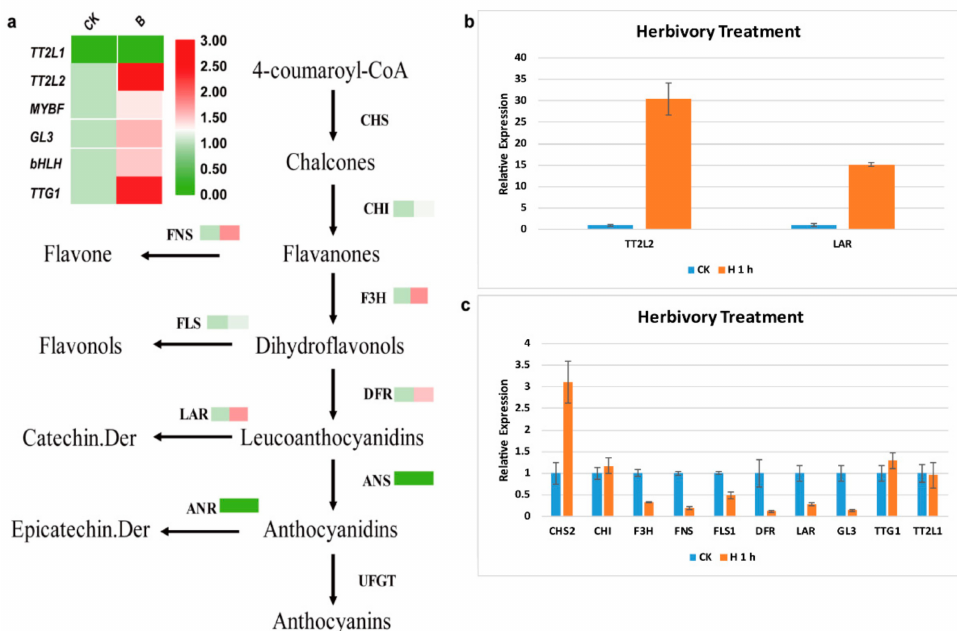
Figure 8. The expression profiles of genes involved in the mulberry flavonoid synthesis pathway after silkworm herbivory treatment. ( a ) The expression profiles of genes involved in the Chuansang flavonoid synthesis pathway. ( b ) The expression trend of TT2L2 and LAR in Chuansang. ( c ) The expression pattern of genes involved in the Guisangyou 62 flavonoid synthesis pathway.